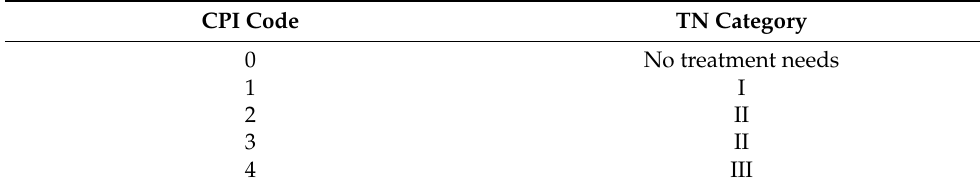
Table 1. CPITN index according to Ainamo et al. CPI